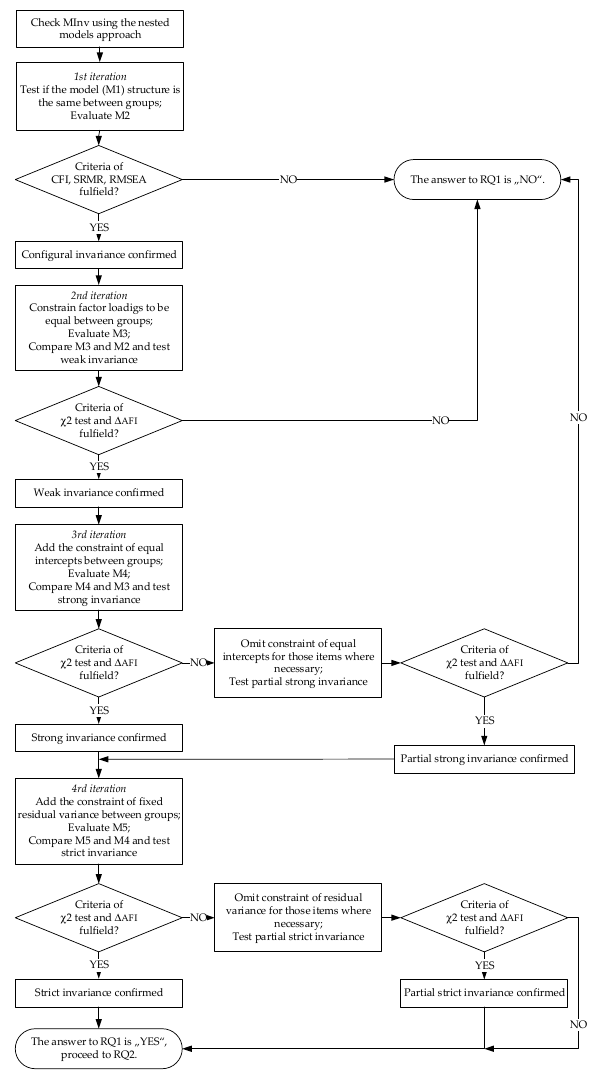
Figure 3. Step 3: Multi-Group Confirmatory Factor Analysis.